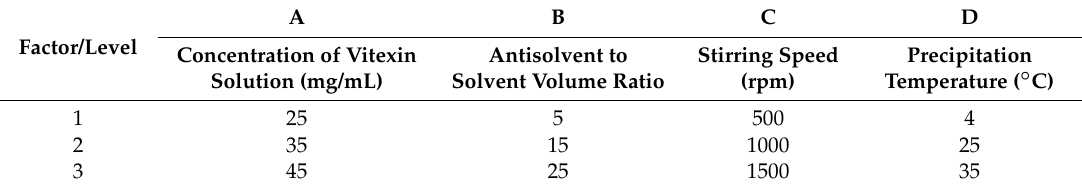
Table 3. Factors and levels of the